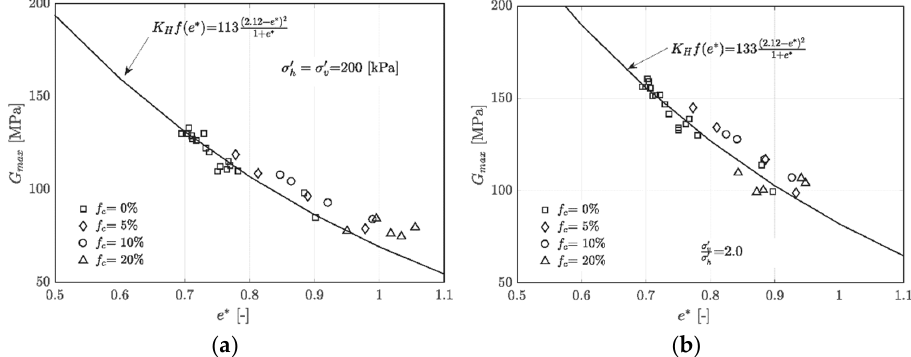
Figure 11. Using e* instead of e to predict G max under ( a ) isotropic and ( b ) anisotropic stress states.